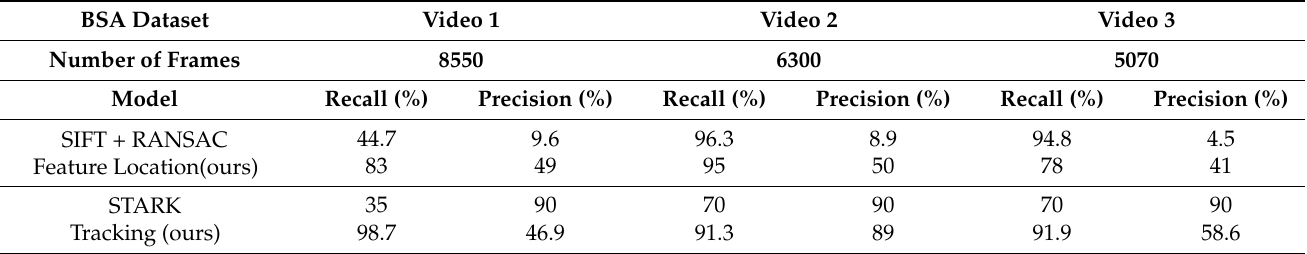
Figure 15. Comparison with other methods. Table 4. Experimental comparison on the BSA dataset.